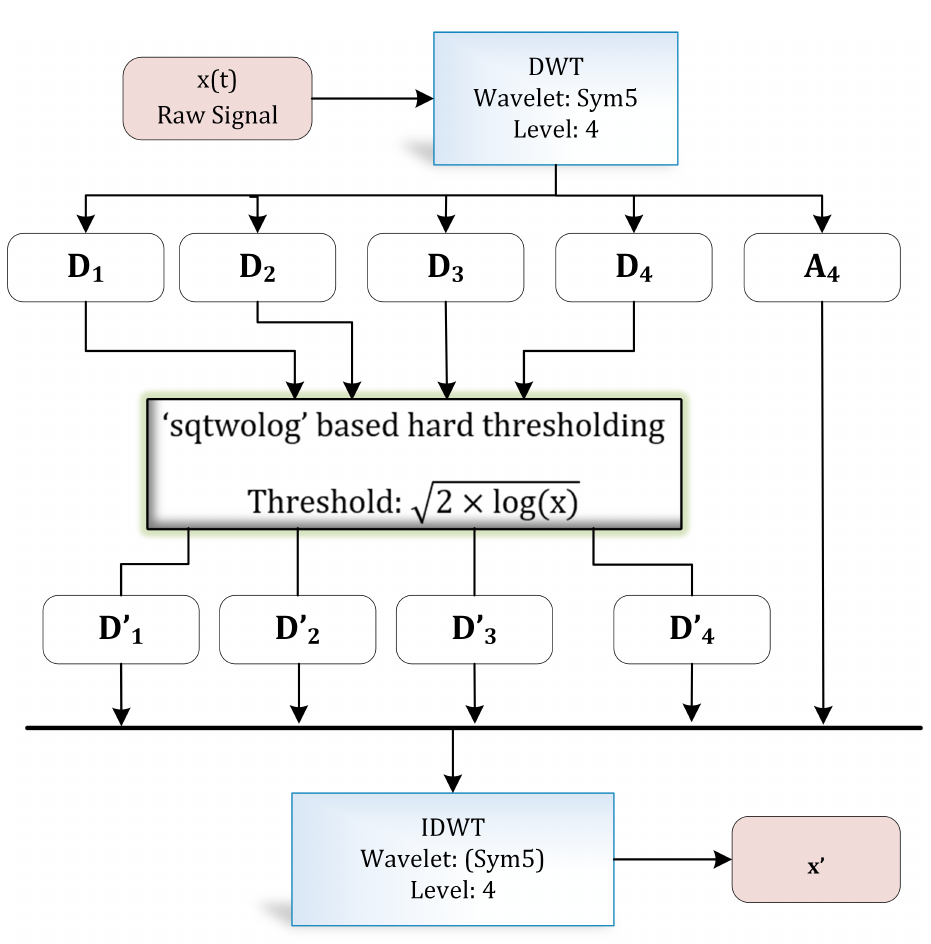
Figure 4. Wavelet-based denoising. Table 4. Comparison of mean relative energies and frequency ranges of various decomposition levels for Normal and Hypertension